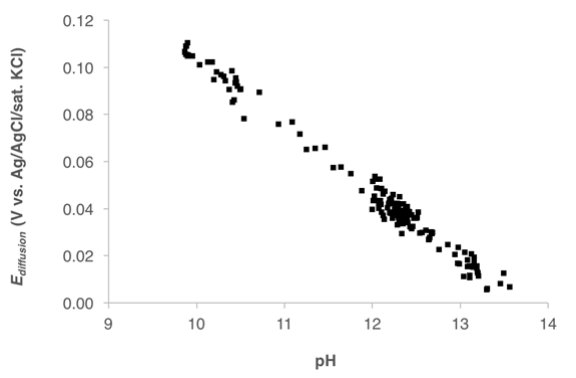
Figure 5. (a) Calculated pH as a function of the square root of time in the carbonation chamber for six IrO x sensors embedded at cover depths 4, 5, 6, 10, 15 and 20 mm. The curves with same color correspond to the same mortar sample (b) Representative example (IrO x sensor embedded at 6 mm cover depth) showing the decrease from pH ≈ 14 down to pH ≈ 12, followed by a fast increase to pH